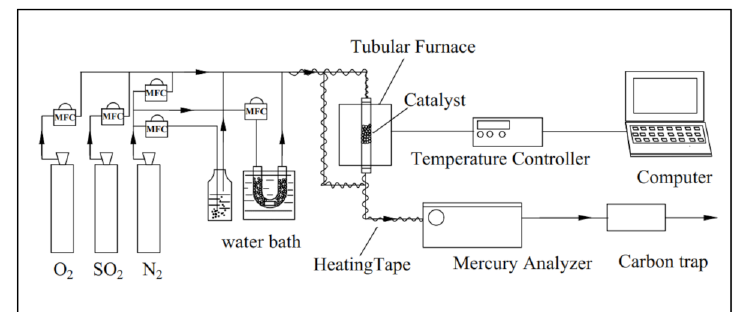
Figure 9. Schematic diagram of the fixed-bed reactor for Hg 0 removal by V 2 O 5